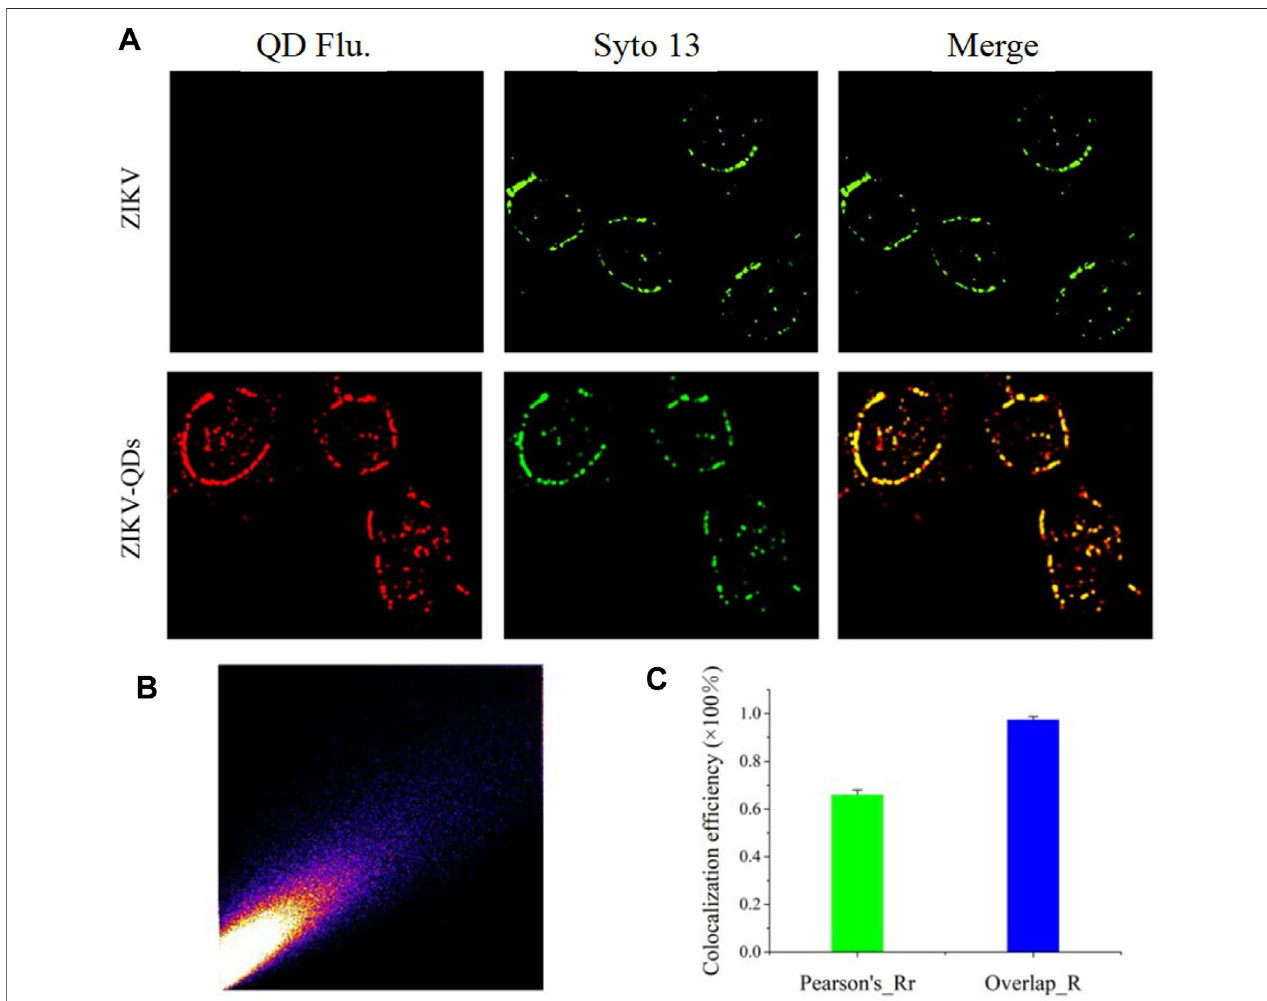
FIGURE 2 | (A) Confocal microscopic images of ZIKV nucleic acid colocalized with the commercially available organelle trackers Syto13 in SNB19 cells (Flu is the abbreviation for fl uorescence). (B) Colocalization scatterplots of (A) . (C) Corresponding Pearson correlation coef fi cient of (A) .